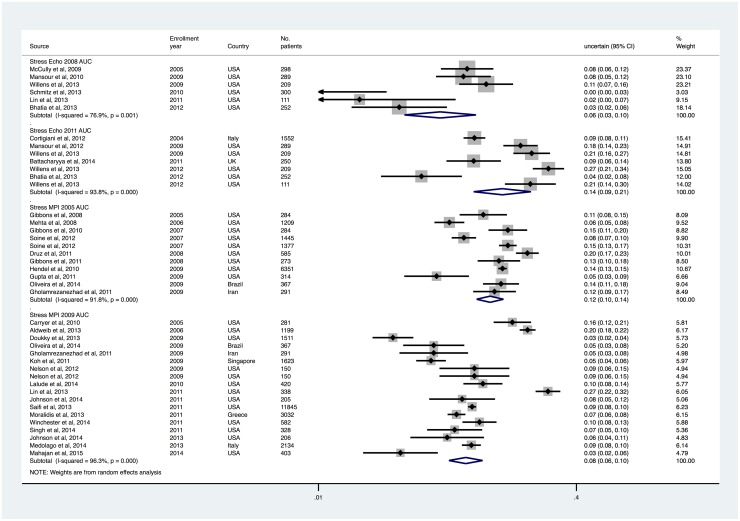
Uncertain/May be Appropriate Use Rates of Stress Echocardiography and MPI, Sorted by Patient Enrollment Year.